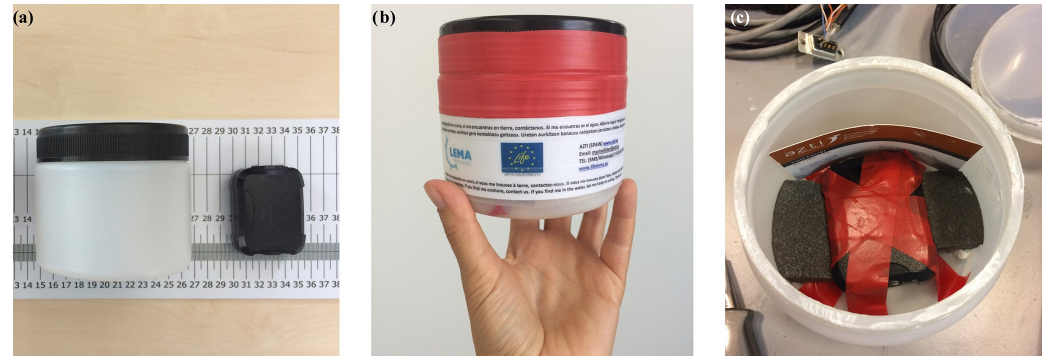
Figure 2. Main components of the low-cost buoy. The structure: (a) HDPE container and SPOT Trace device powered by four AAA cells. Assembly process: (b) final appearance once the buoy is sealed; the buoy is labelled with contact information both within and outside; (c) the SPOT Trace was fixed at the base of the container with adhesive tape to avoid twists and turns of the buoy. Table 1. Locations, periods, and distances covered by the drifting buoys. Buoy ID River Initial date (UTC + 1)